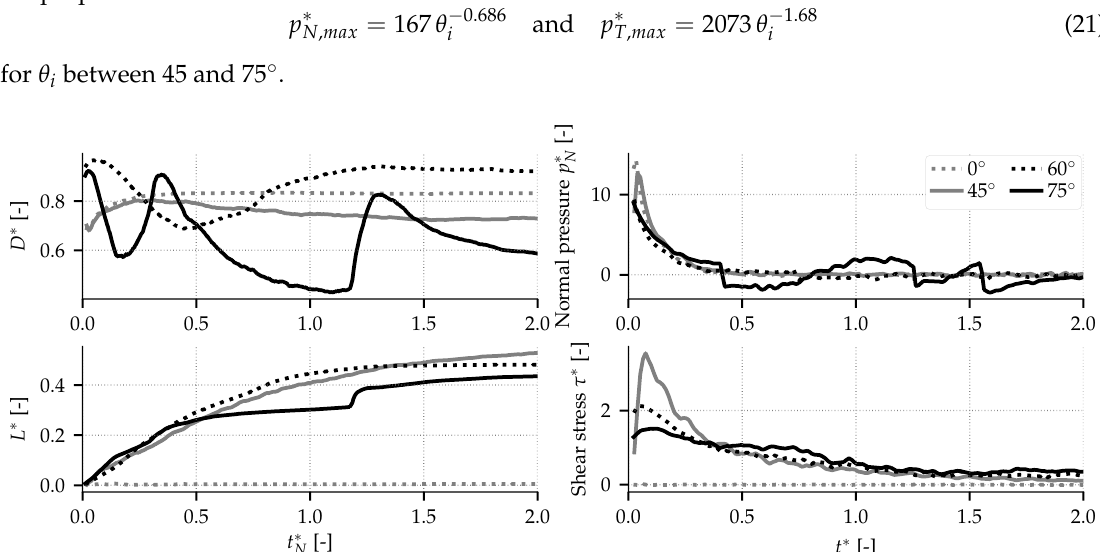
Figure 14. Influence of the impact angle on the transient of a cube presenting its face.